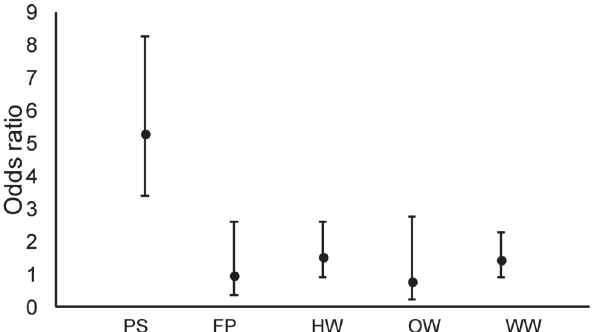
Fig 1. Odds ratios by cover type for eastern diamondback rattlesnake habitat selection at the home range scale in the South Carolina Coastal Plain tidewater region. Reference = forest; PS = pine savanna, FP = wildlife food plot, HW = herbaceous wetland, OW = open water, WW = woody